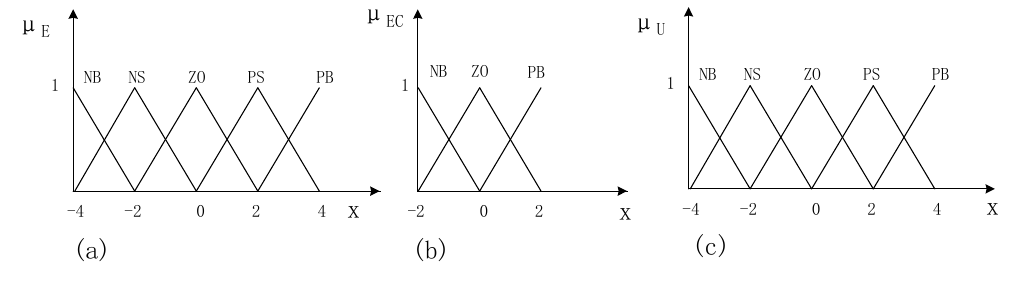
Figure 5. Membership function of linguistic variable: ( a ) E; ( b ) EC; ( c ) U.